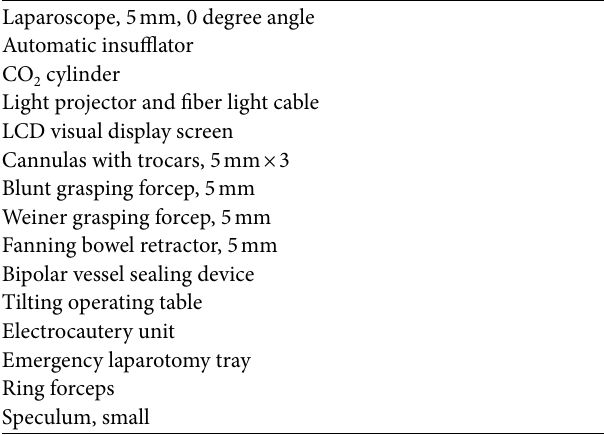
Table 1: List of equipment used during the